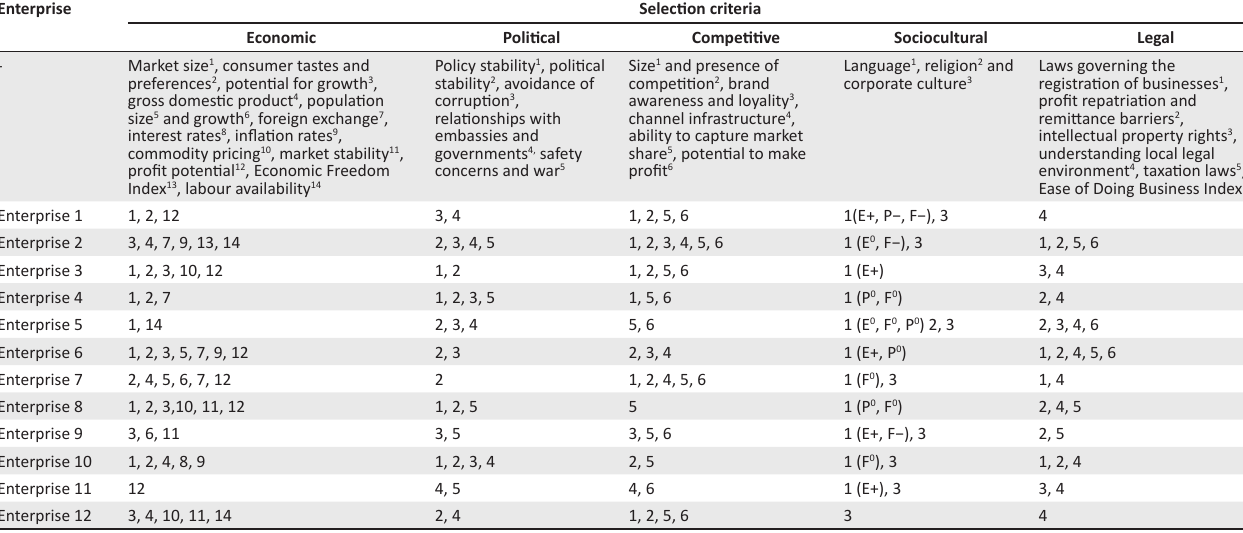
TABLE 3: International market selection criteria. Enterprise Selection criteria - Market size 1 , consumer tastes and preferences 2 , potential for growth 3 , gross domestic product 4 , population size 5 and growth 6 , foreign exchange 7